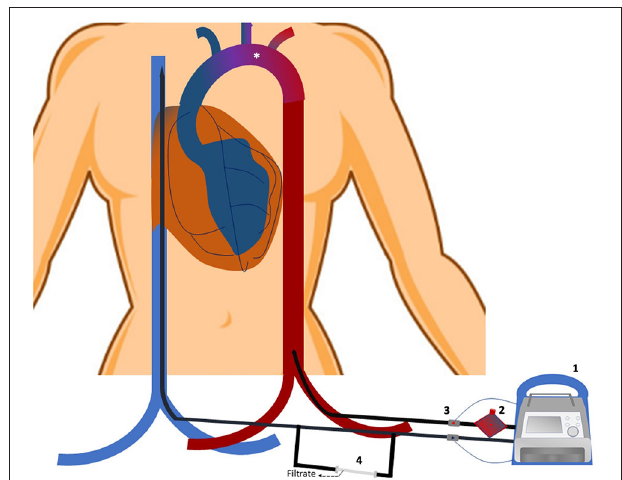
FIGURE 1 | Veno-arterial extracorporeal cardio-membrane oxygenation (VA-ECMO) circuit and North South syndrome. A venous cannula is inserted into the superior vena cava/right atrium to drain deoxygenated blood by the extracorporeal pump (1). After passing through the “membrane lung (2),” oxygenated blood is returned into the iliac artery through the arterial cannula. Proximal (venous) and distal (arterial) sensors monitor circuit flow (3). A continuous hemodialysis machine may be spliced into the venous limb of the circuit if needed to provide renal replacement therapy (4). In situations when the left ventricle recovers pulsatility yet the pulmonary gas exchange remains inadequate, deoxygenated blood may be ejected into the ascending aorta. As the fully oxygenated retrograde flow provided by the ECMO circuit collides with the deoxygenated blood in the aorta, a mixing cloud forms (*). Its location is determined by the native cardiac function and the level of competing ECMO support. If undetected, ischemia of the organs perfused by the anterograde flow may